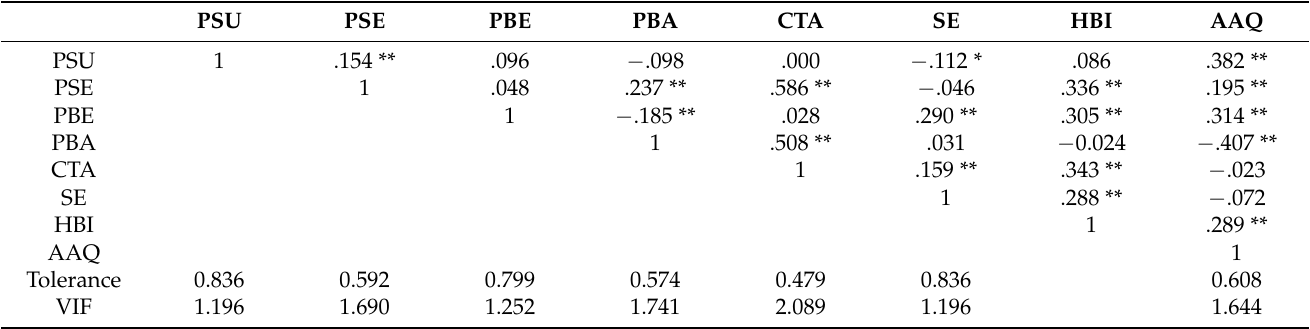
Table 3. Pearson correlation, tolerance and VIF among investigated